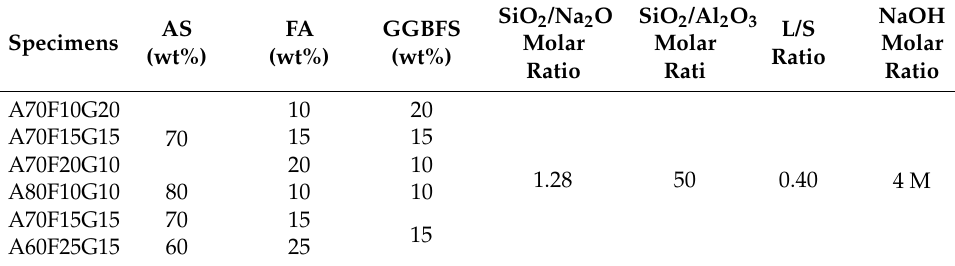
Table 8. The preparation parameters of AFG geopolymer